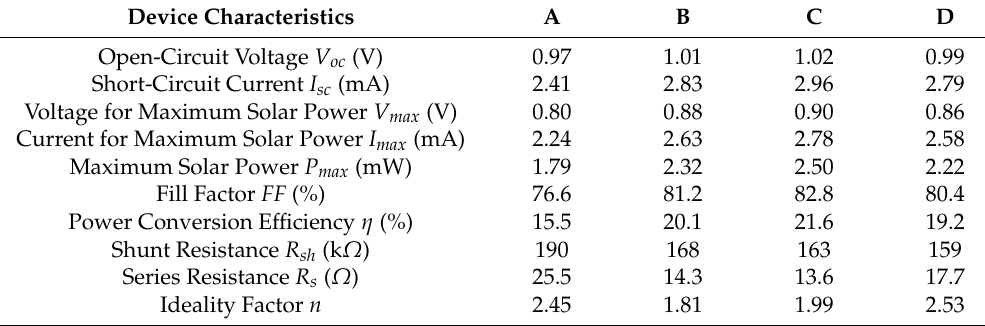
Table 2. Summary of photovoltaic performance of samples A, B, C and